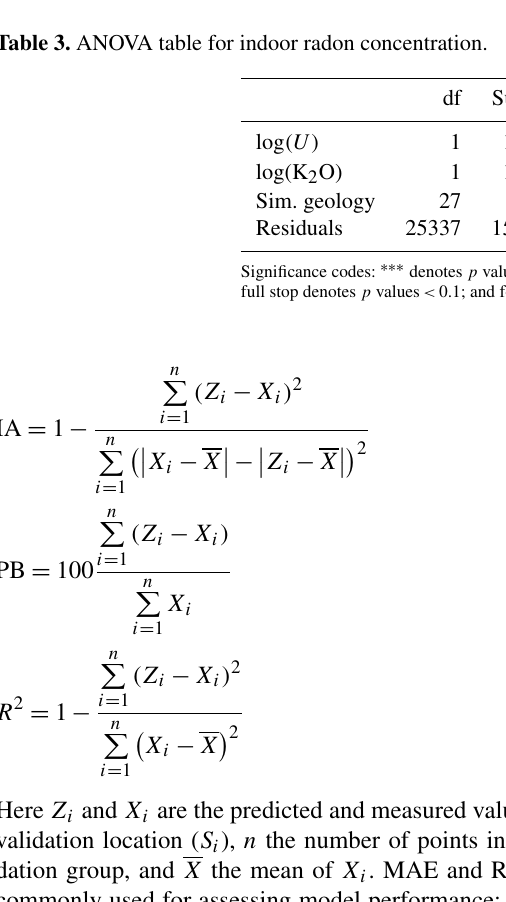
Table 3. ANOVA table for indoor radon concentration.